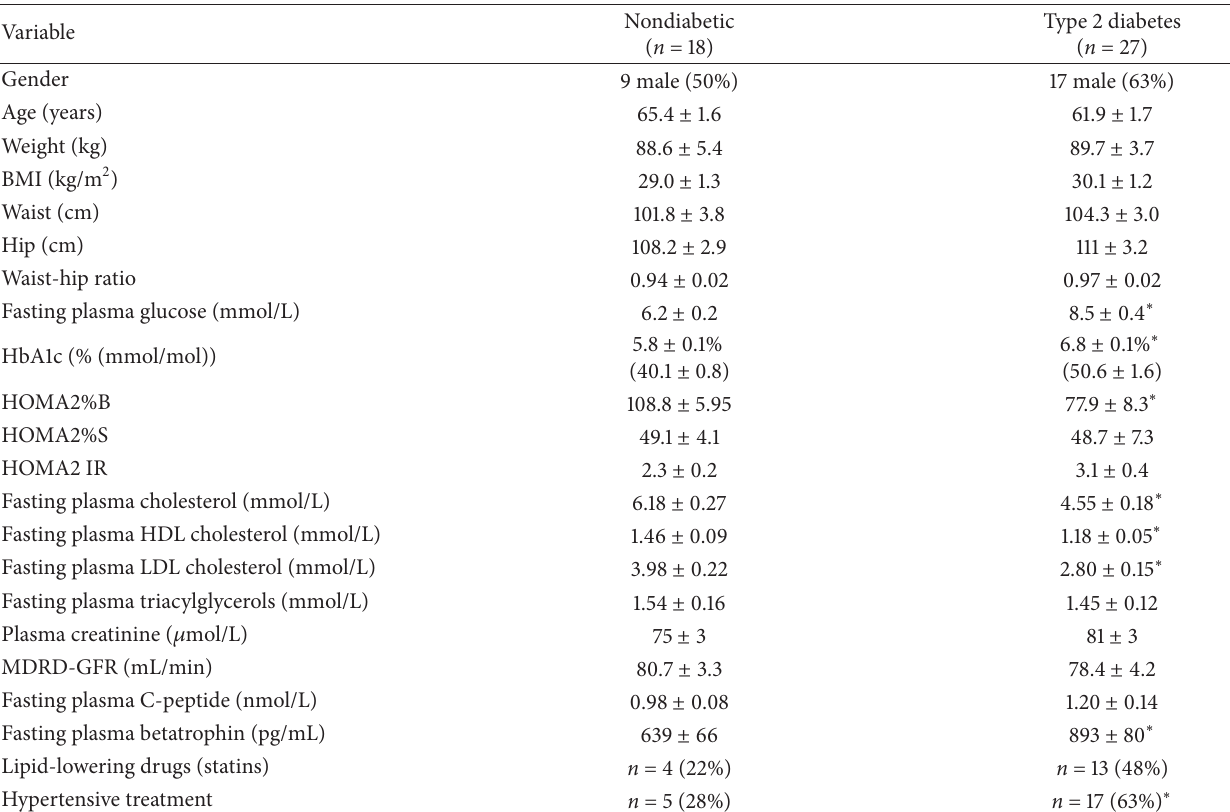
Table 1: Descriptive data and blood sample data for nondiabetic controls and patients with type 2 diabetes. All blood samples were collected after overnight fasting. HbA1c levels are given as NGSP (%) and as IFCC values (mmol/mol) in